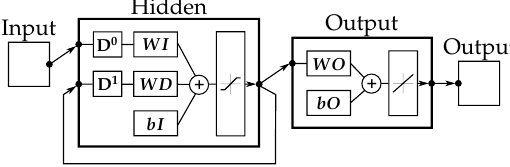
Figure 6. Shallow NN with one recurrent path with a delay of one ( D 1